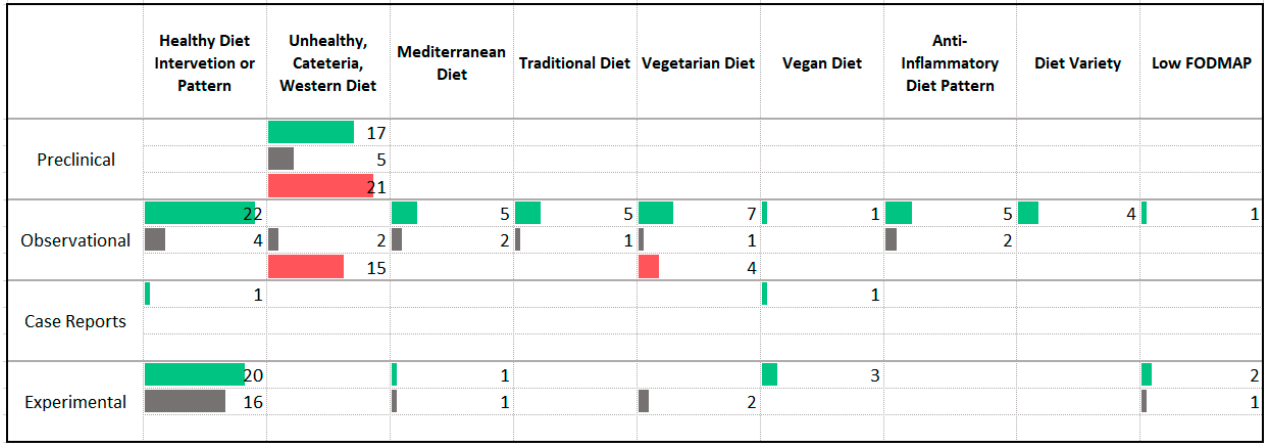
Figure 5. Studies assessing the composition of dietary patterns. █ Higher intake or levels associated with decreased anxiety. █ No association between intake or levels and anxiety. █ Higher intake or levels associated with increased anxiety.